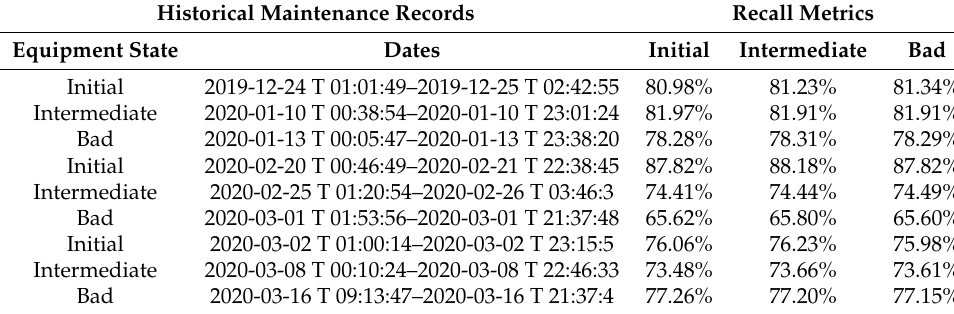
Table 3. LSTM-autoencoders recall